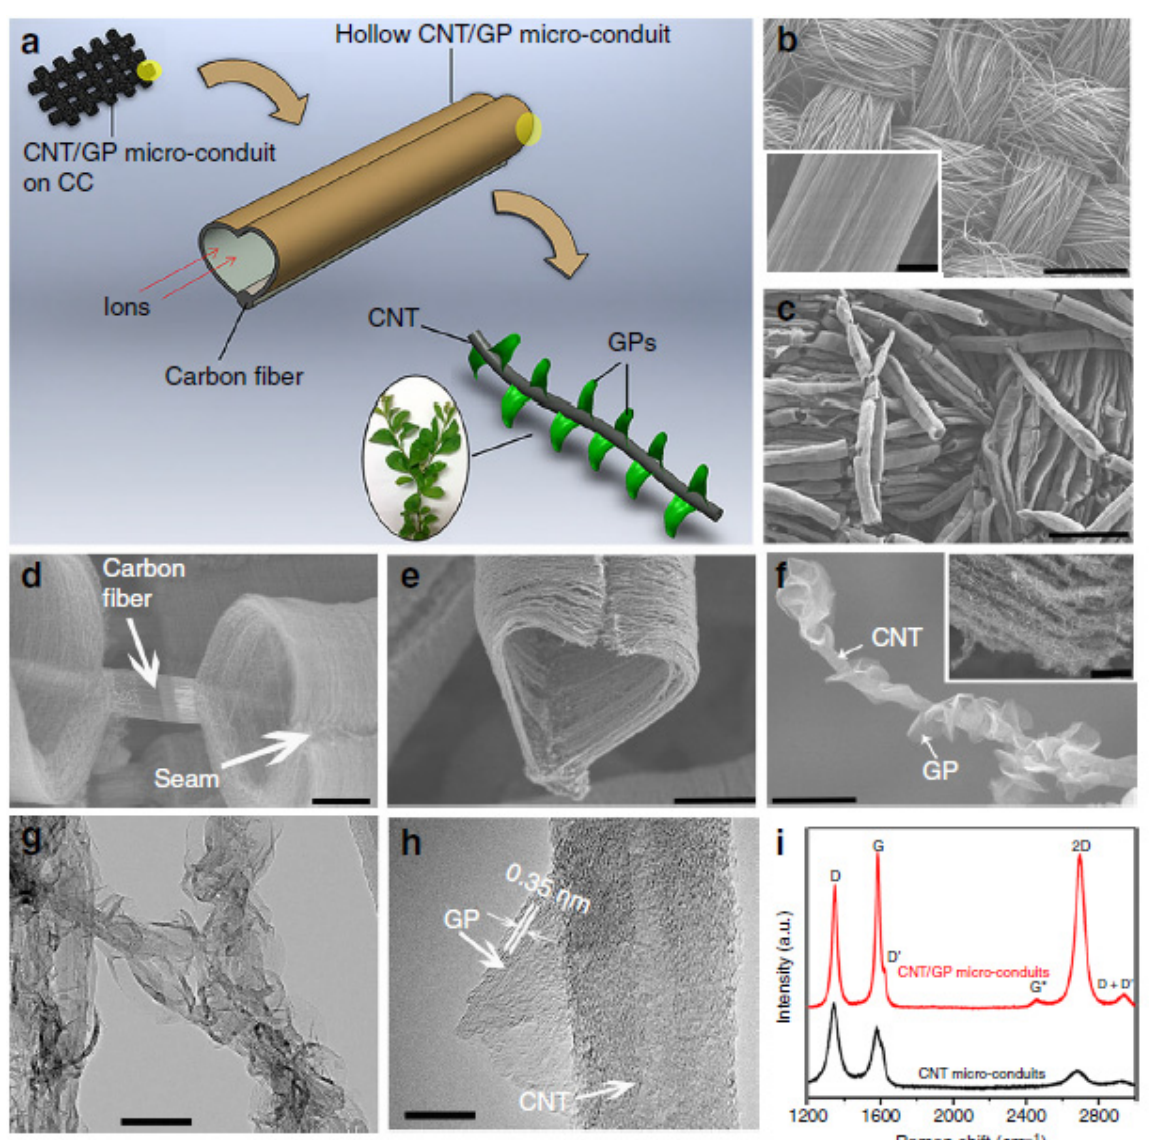
Figure 6. Structural characterization of CNT/GP micro-conduits. ( a ) Schematic illustration of CNT/GP micro-conduits in a leaves-on-branchlet nanostructure on CC substrates for high-performance supercapacitor electrodes (note that the yellow shaded areas in the schematic indicate the selected areas to be magnified). ( b ) Bare CC substrate at low magnification (inset shows the surface of a single carbon fiber). ( c ) Uniform coverage of CNT micro-conduits on carbon fibers at low magnification. ( d ) A close-up of CNT micro-conduits on a carbon microfiber. ( e ) A CNT/GP micro-conduit in a heart shape. ( f ) A single CNT decorated with many GPs at high magnification (inset shows GPs on CNT micro-conduit array walls). ( g ) TEM image of the hierarchical structure. ( h ) HR-TEM image of a petal emerging from a nanotube. ( i ) Comparative Raman spectra of CNT micro-conduits and CNT/GP micro-conduits on CC substrates. Scale bars: ( b ) 500 µ m (inset: 3 µ m), ( c ) 300 µ m, ( d ) 10 µ m, ( e ) 20 µ m, ( f ) 300 nm (inset: 2 µ m), ( g ) 100 nm, ( h ) 10 nm. Reproduced from [99] under a